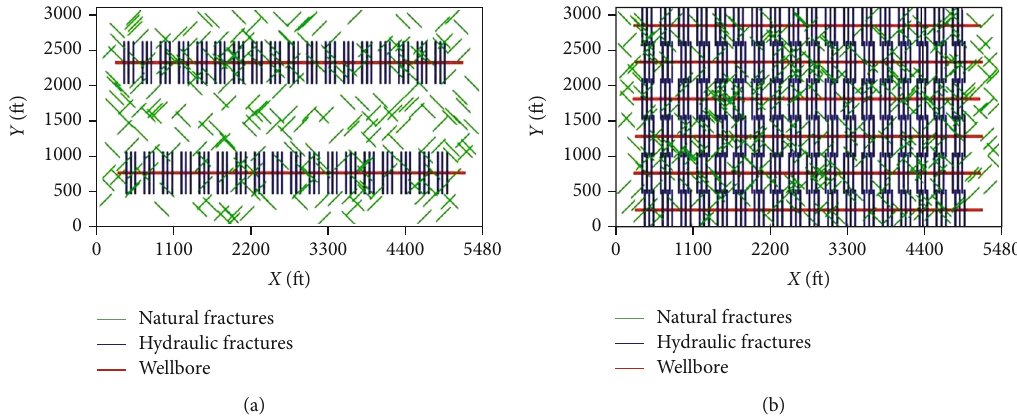
Figure 2: A fi eld-scale reservoir model for fi ve well spacing schemes used in this study: (a) a 2-well placement scenario with a spacing of 1550ft and (b) a 6-well placement scenario with a spacing of